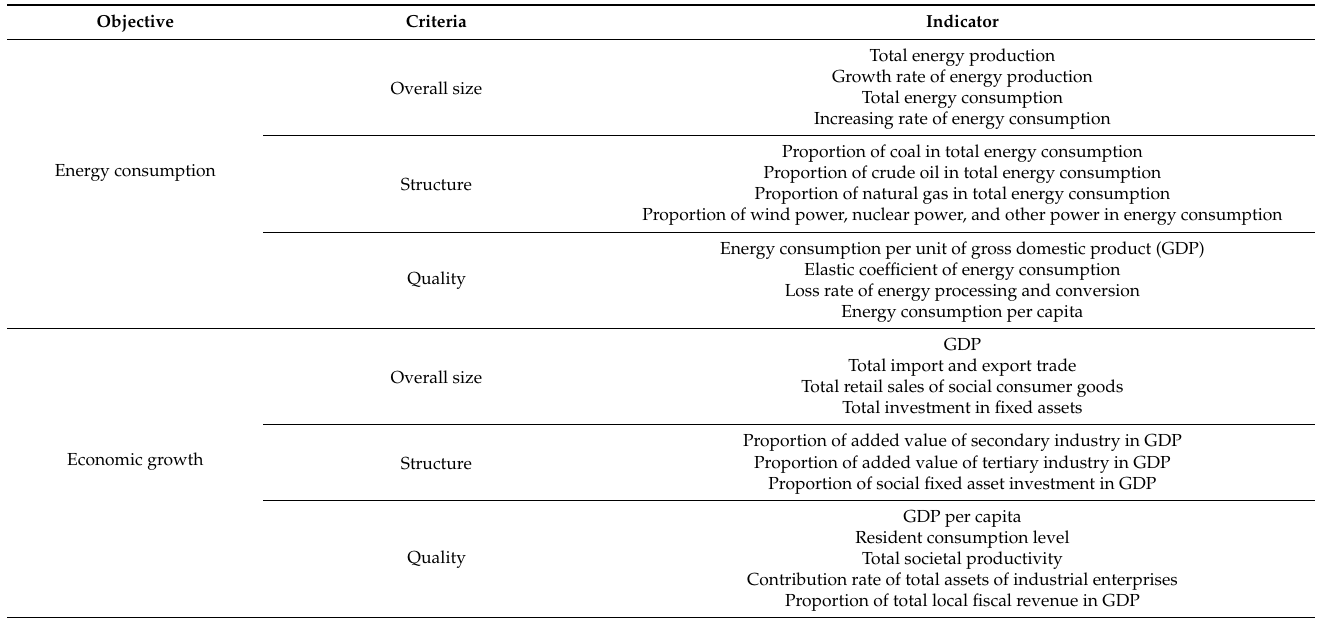
Table 1. The 3E coupling and coordinated development indicator